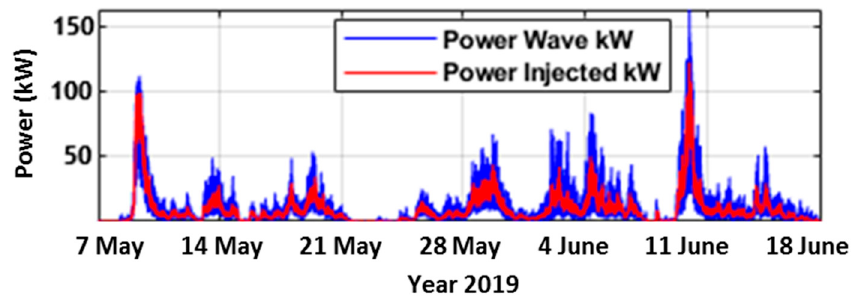
Figure 12. Profile of the generation of the plant (in blue) and theoretical objective profile to be delivered to the grid after applying the power ramp-rate limit.